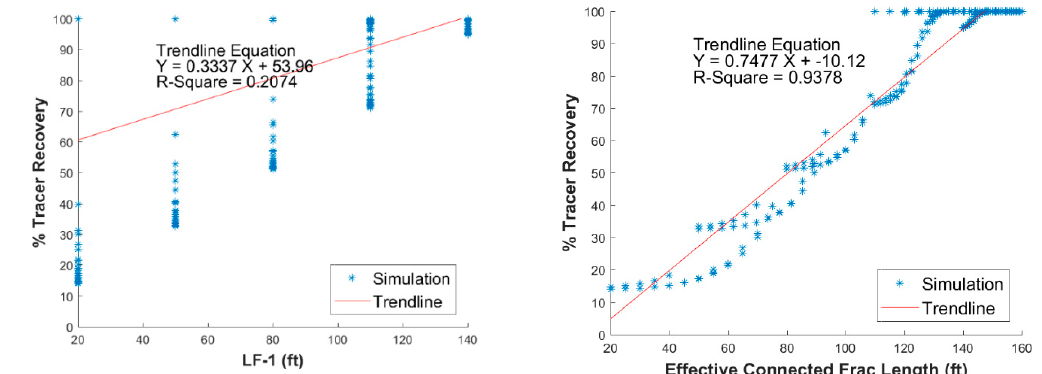
Figure 27. Advantage of lumping the fracture lengths and permeabilities to a single parameter (effective connected fracture length). The left plot shows a very weak correlation between tracer recovery and first connected fracture length. The right plot shows that lumping the parameters helps in finding a good correlation to the tracer recovery.